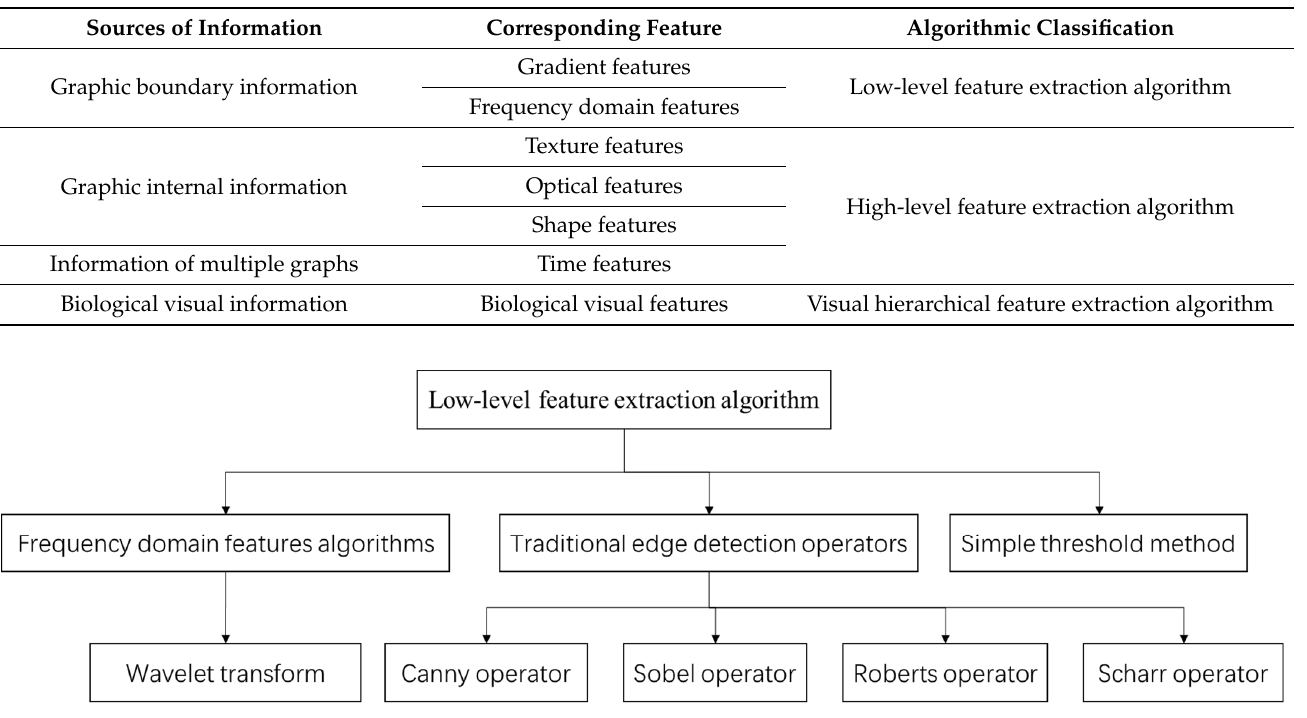
Table 7. Classification of algorithms, corresponding characteristics, and sources of information.